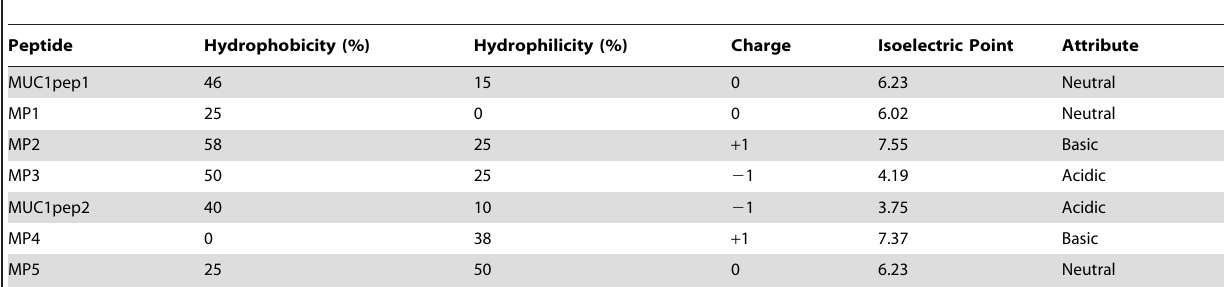
Table 4. Physical properties of MUC1pep1, MUC1pep2 and their putative mimic peptides MP1-5.